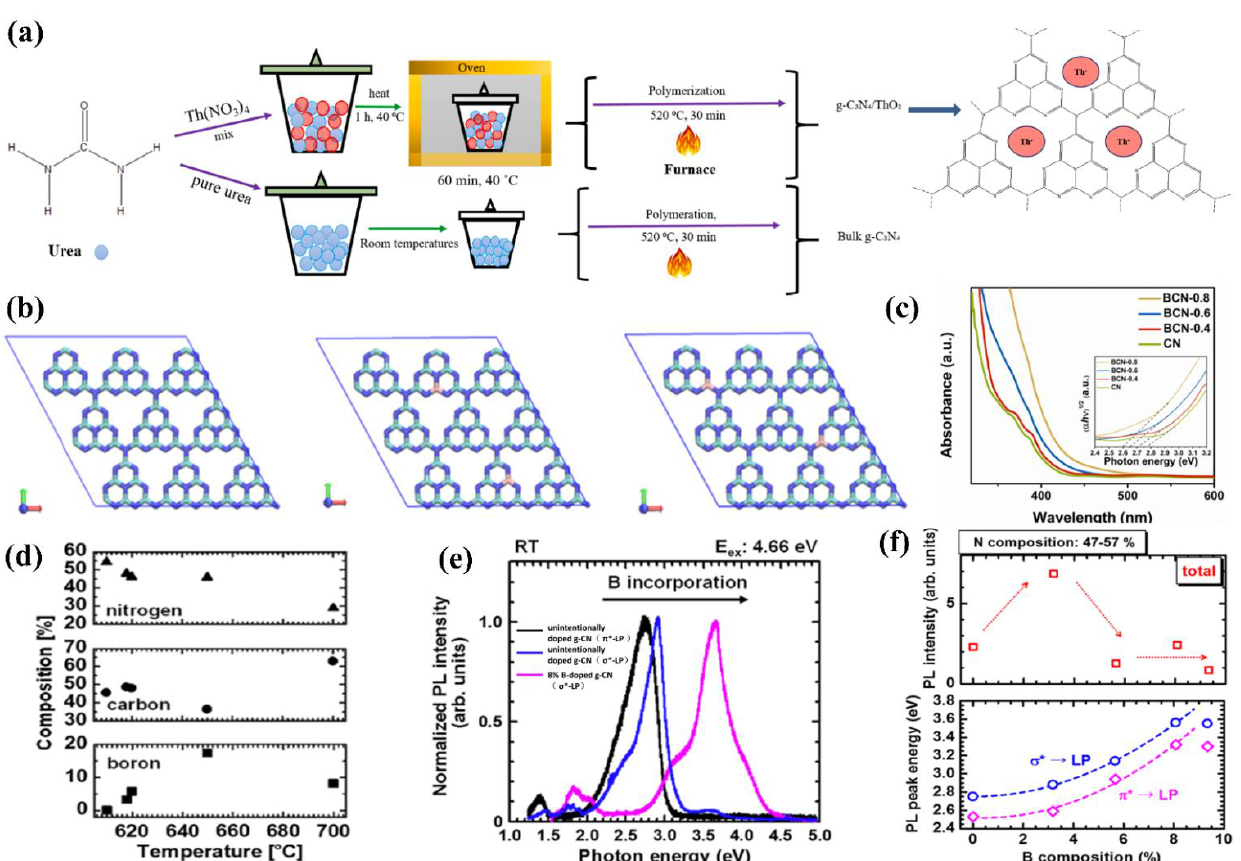
Figure 9. ( a ) Schematic illustration of the formation process. Reprinted with permission from ref. [104] Copyright 2021 Elsevier. ( b ) Top-views of super-cell 3 × 3 pure g−CN (left) and B-doped g−CN with two C substituted by B at corner (middle) and bay (right) sites in a lattice with constants of a = b = 21.04 Å, c = 20.0 Å, and α = β = 90°, γ = 120° by DFT optimizations. The green, blue, and pink colors represent C, N, and B atoms, respectively, and ( c ) the UV – vis absorption spectra (the inset shows the Tauc plots). Reprinted with permission from ref. [106] Copyright 2018 Elsevier. ( d ) Substrate temperature dependence of compositions, ( e ) typical RT-PL spectra for B-doped g−CN films with various compositions, the black line is the a peak energy corresponds to unintentionally doped g−CN films (π* -LP), the blue line is the a peak energy corresponds to unintentionally doped g−CN films (σ* -LP), and the pink line is the a peak energy corresponds to B-incorporated g−CN with a composition of 8.0% ( σ* -LP) and ( f ) room temperature integrated PL intensity and PL peak energy depended on B composition. Reprinted with permission from ref. [110] Copyright 2020 Wiley-VCH.